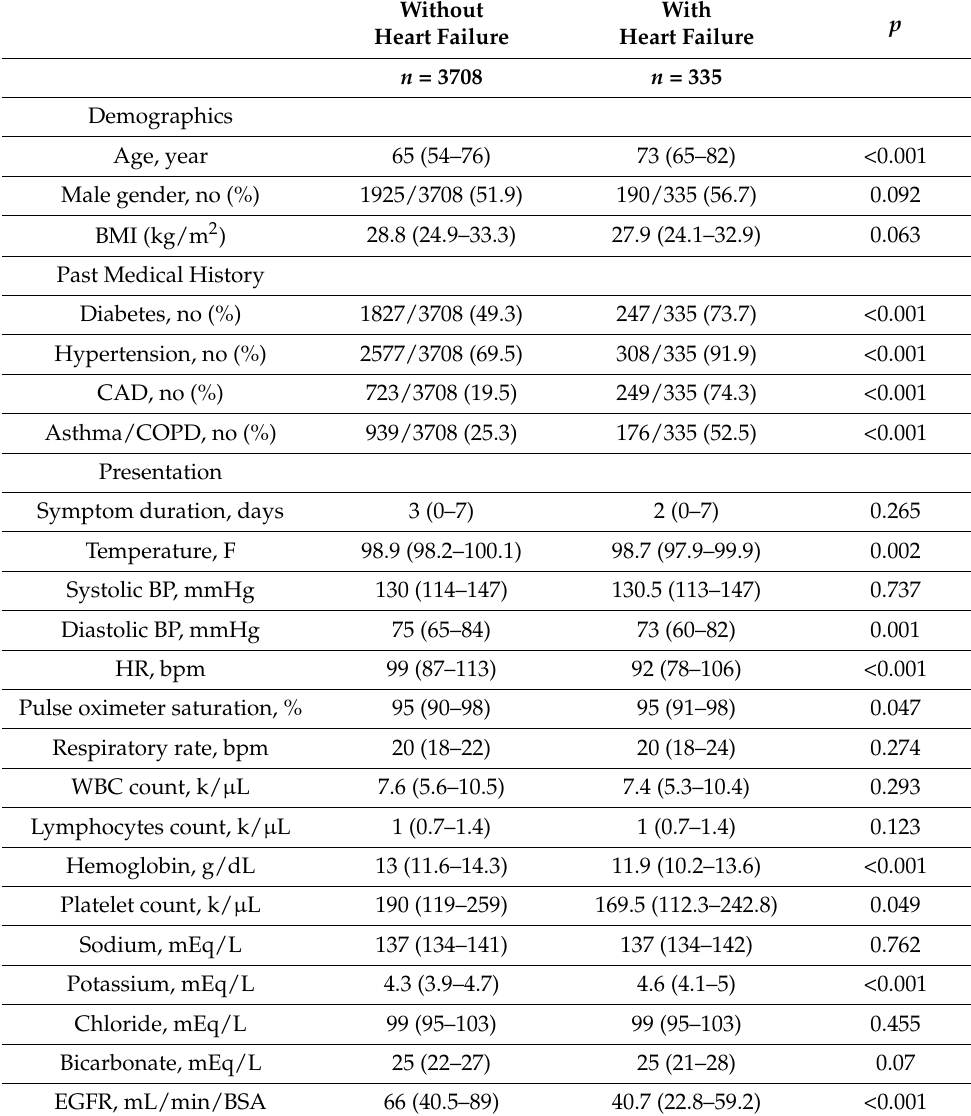
Table 1. Characteristics of patients admitted with